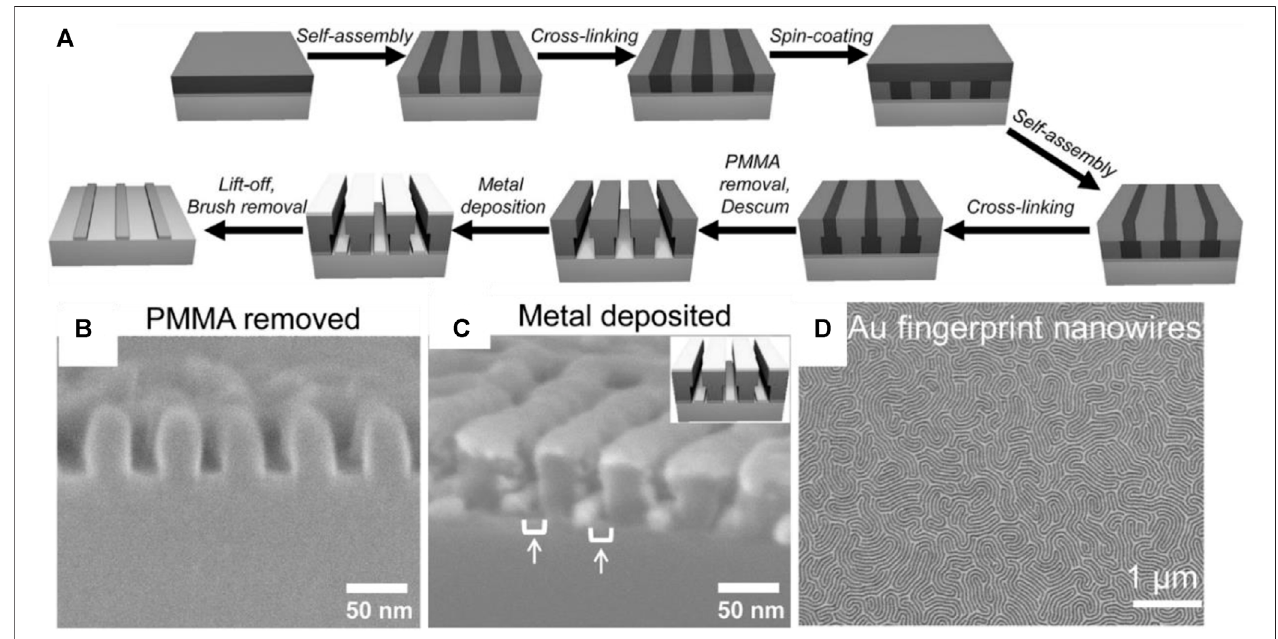
FIGURE2|(A) Schematicprocess fl owofthelift-offbased fabrication ofAunanowire networkwithlamellarblockcopolymer thin fi lmastemplate;Cross-sectional scanningelectronmicroscopy(SEM)micrographofPS-b-PMMAbilayer (B) afterselectivePMMAremovaland (C) afterthethermaldepositionofCr/Authin fi lm; (D) Top- view SEM of the fi ngerprint templated Au nanowire network after lift-off. Reproduced with permission from ref (He and Stoykovich, 2014).